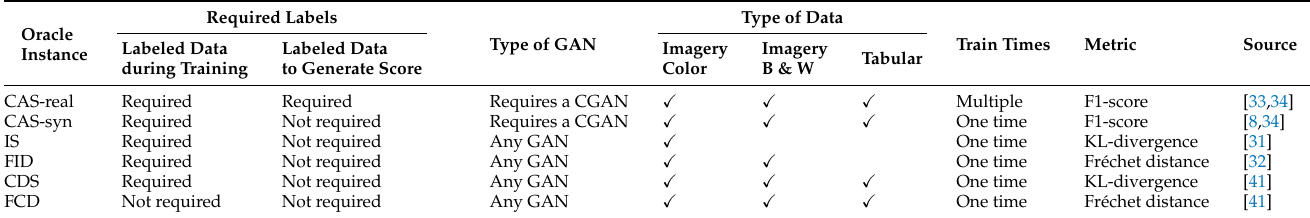
Table 1. A comparison between the requirements of the described oracle